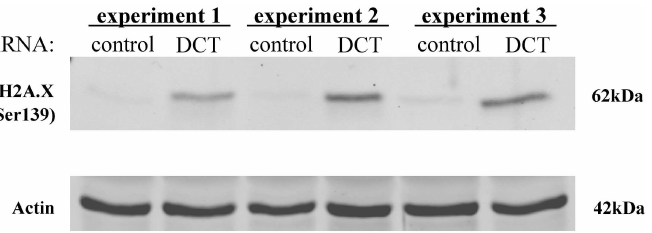
knockdown. Western blot analysisof pH2A.X phosphorylated at Ser139 (DNA damagemarker) and actin (loadingcontrol) are shown for three independent DCT knockdown experiments.